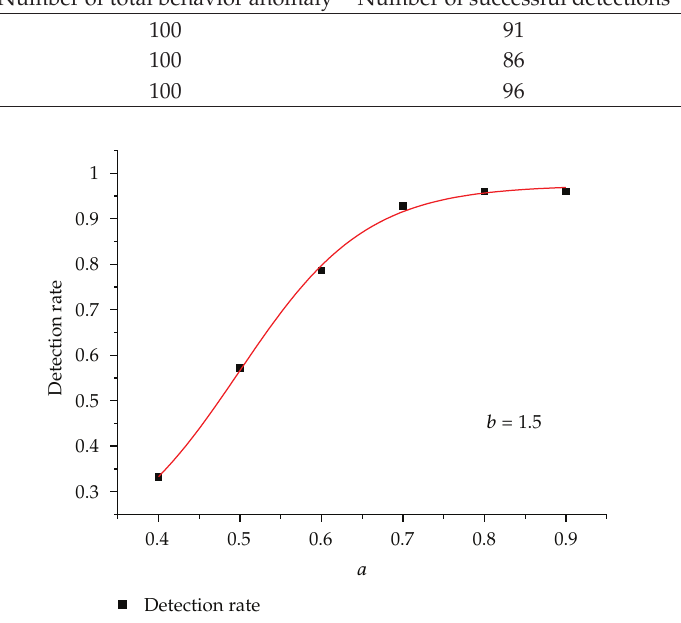
Figure 4: Detection rate with respect to a when b (cid:8) 1 .